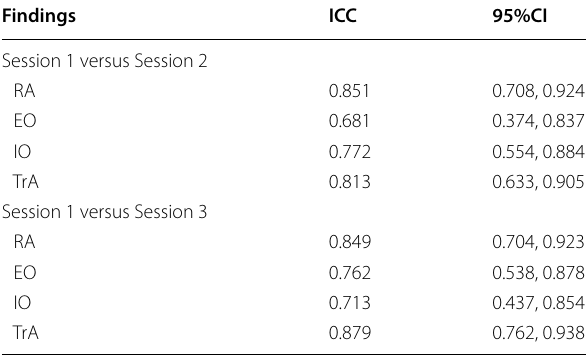
Table 1 Intra-operator reliability analyses of shear wave